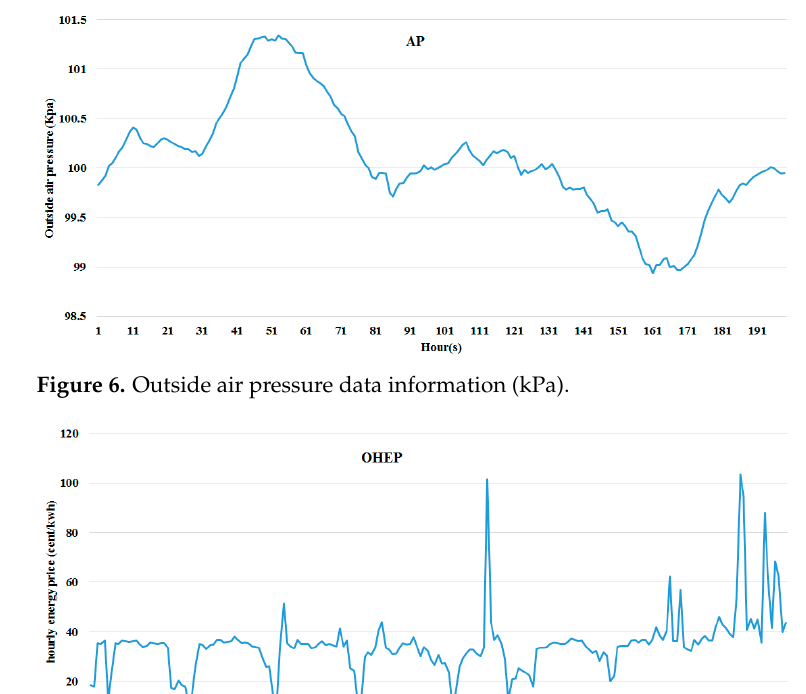
Figure 5. Wind speed data information (km/h).